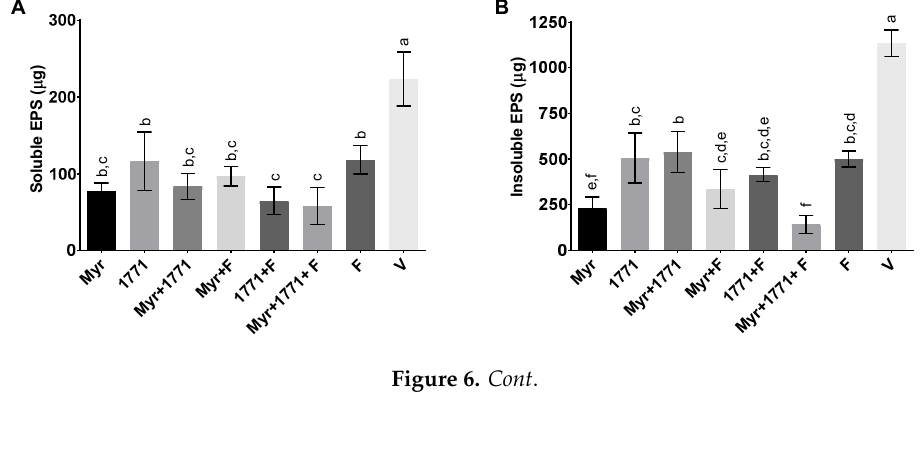
D Figure 6. Cont